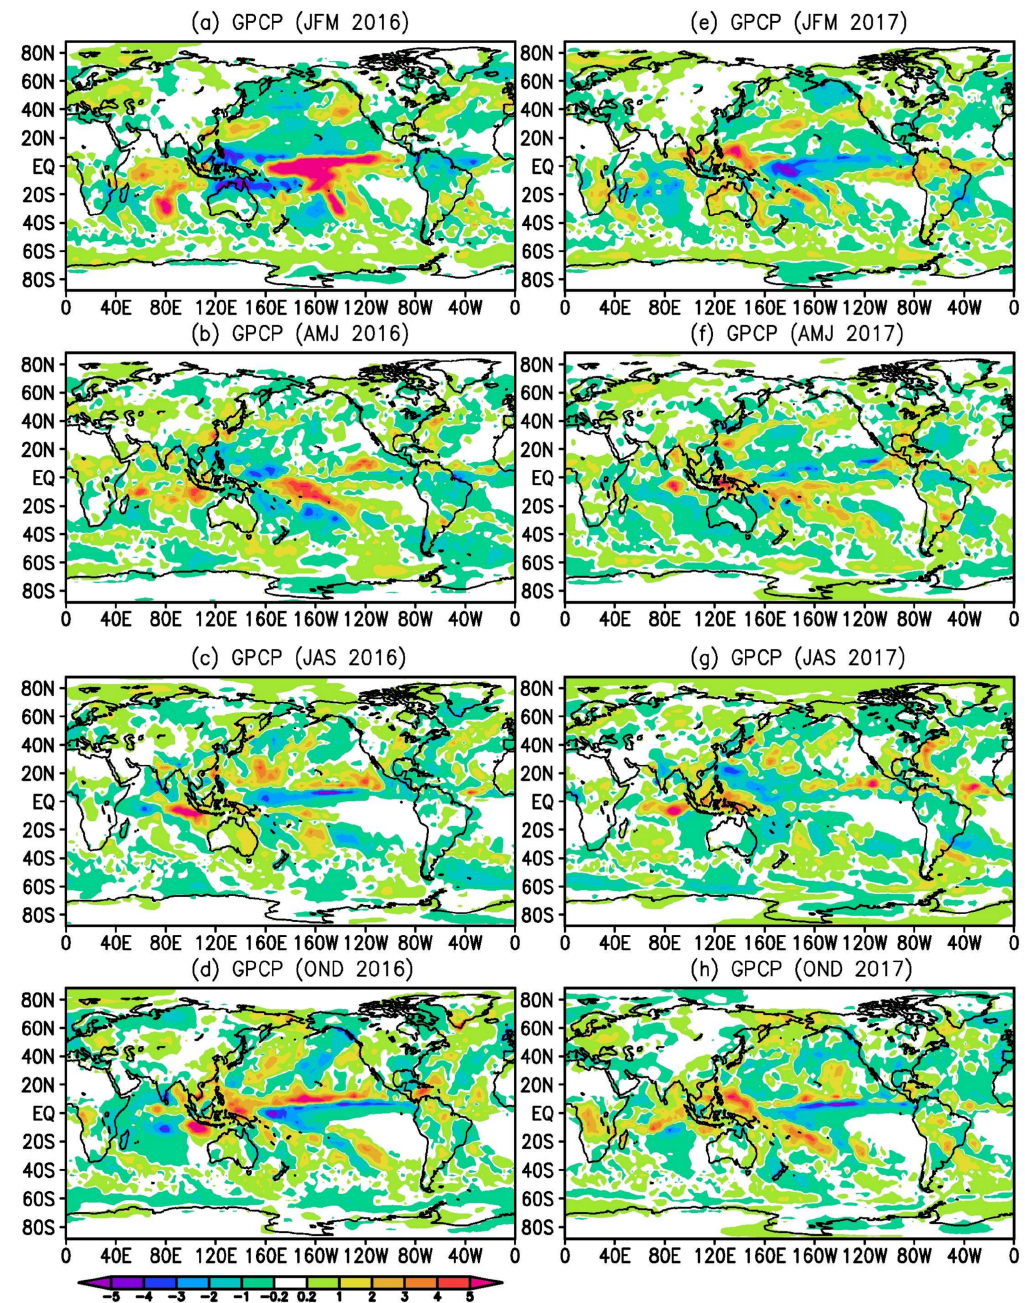
Figure 7. Seasonal precipitation anomalies (mm day − 1 ) in 2016 (left) and 2017 (right). Data from 2017 have also been incorporated into the investigation of trends in rainfall intensity using the monthly GPCP analyses [21]. Focusing on the tropics and the post-1987 period (the satellite microwave era), percentiles (and other parameters related to intensity) at each grid box were computed and aggregated in the tropical latitude band (30 ◦ N–30 ◦ S) (see Figure 10). The mean tropical rainfall has a positive trend over the period (Figure 10d) but it is also evident that there are even stronger positive trends in the higher percentiles (increases in intense rainfall) with significant trends at percentiles greater than 70% (Figure 10a). At intermediate percentiles (30–40%), a downward trend is noted (Figure 10c). At low percentiles (not shown), trends were indeterminate but defined “dry